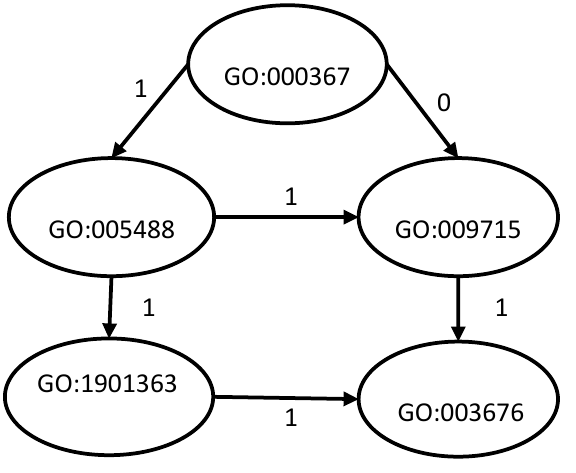
Figure 2. Sub ontology of gene ontology terms